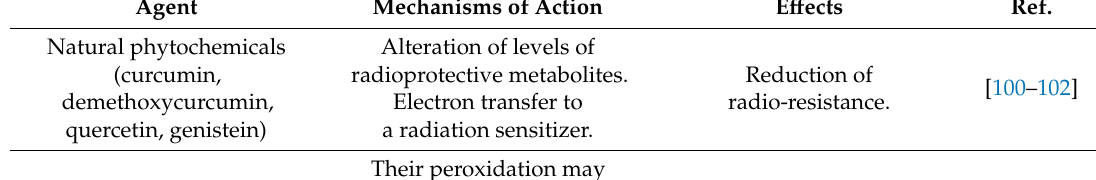
Table 2. Enhancers of radiotherapy activity in hematologic